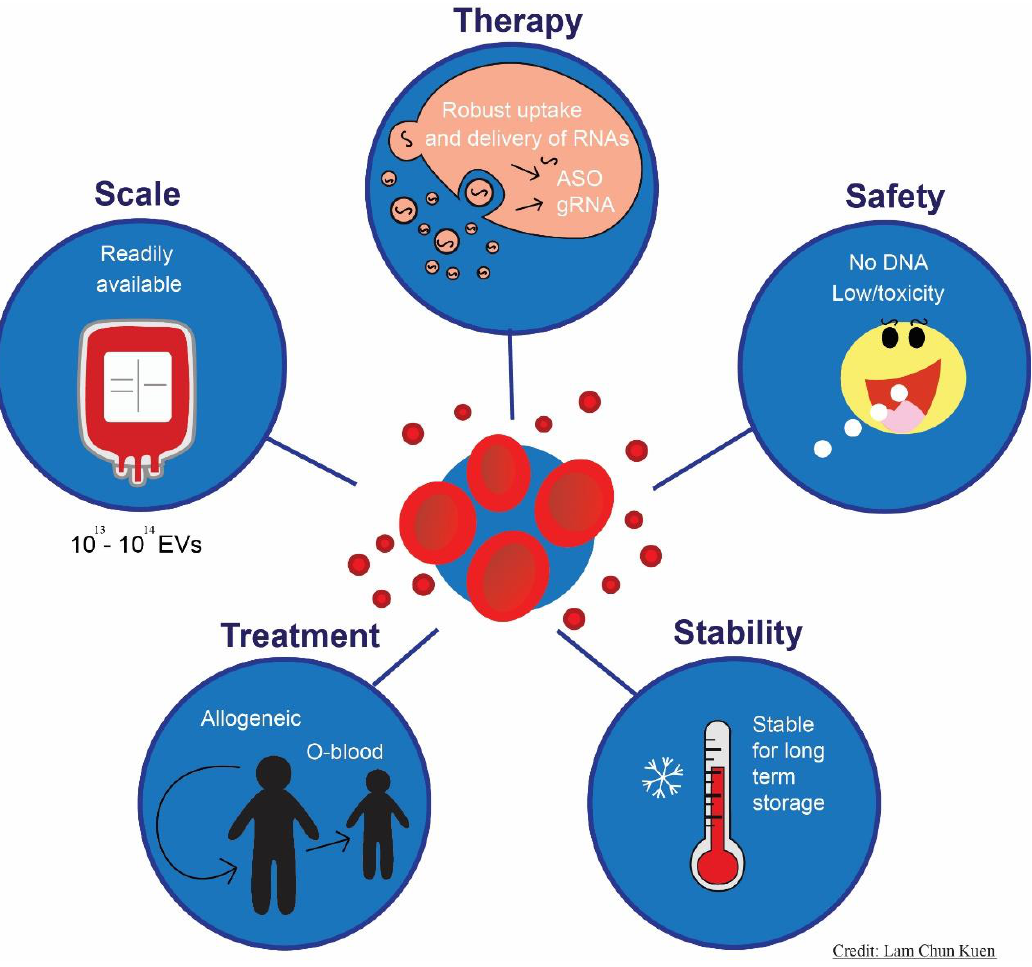
FIGURE 1: Schematic overview of the advantages and potential applications of the red blood cell extracellular vesicles (RBCEVs) delivery system of RNA-based